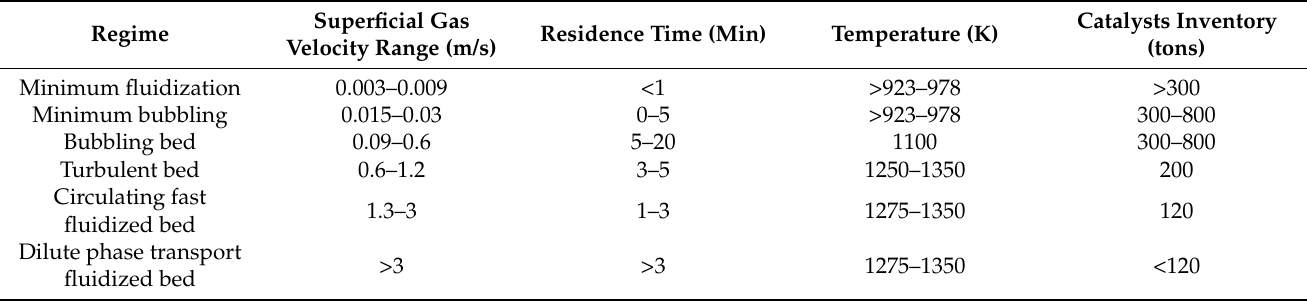
Table 2. Pros and cons of fluidization regimes in FCC